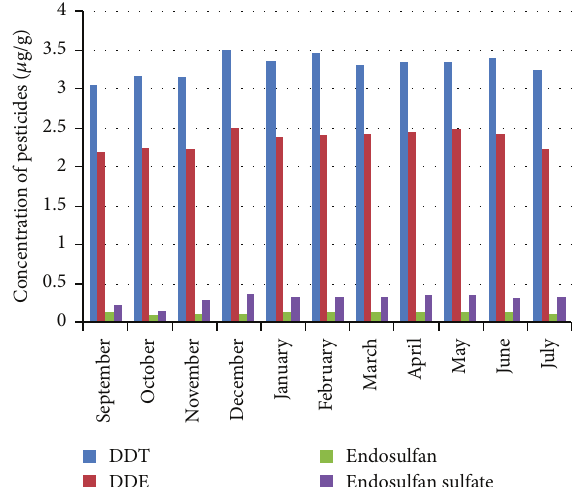
Figure 3: Monthly comparison of pesticides concentration in Catla catla collected from Ravi